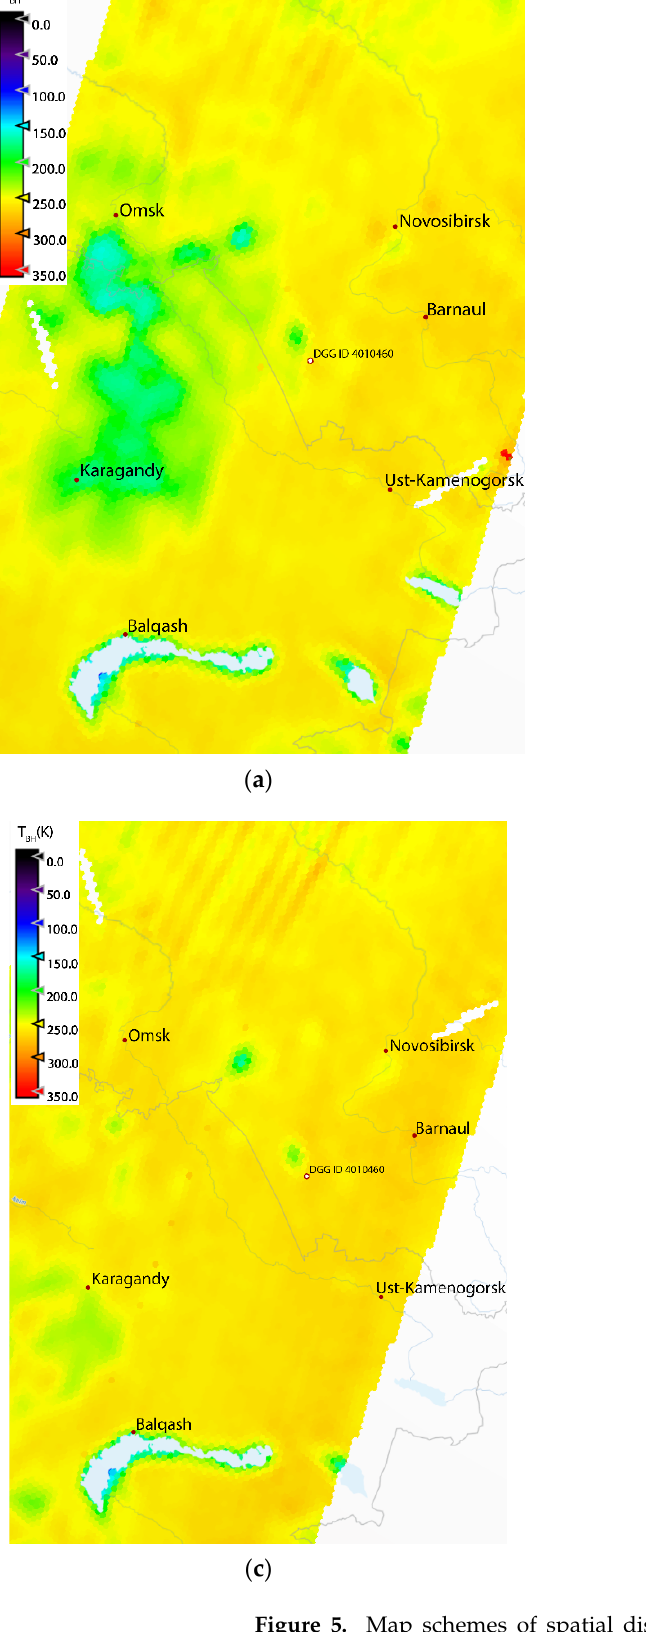
Figure 5. Map schemes of spatial distribution of brightness temperatures: ( a )—2012.06.10; ( b )—2012.07.11; ( c )—2012.06.10; ( d )—2012.07.11.